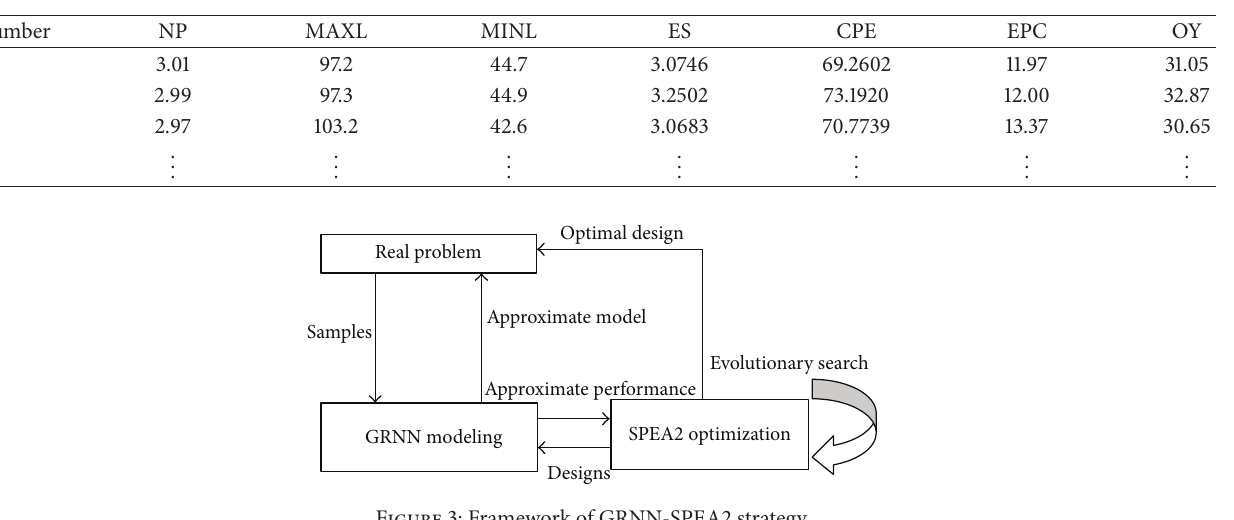
Figure 3: Framework of GRNN-SPEA2 strategy.